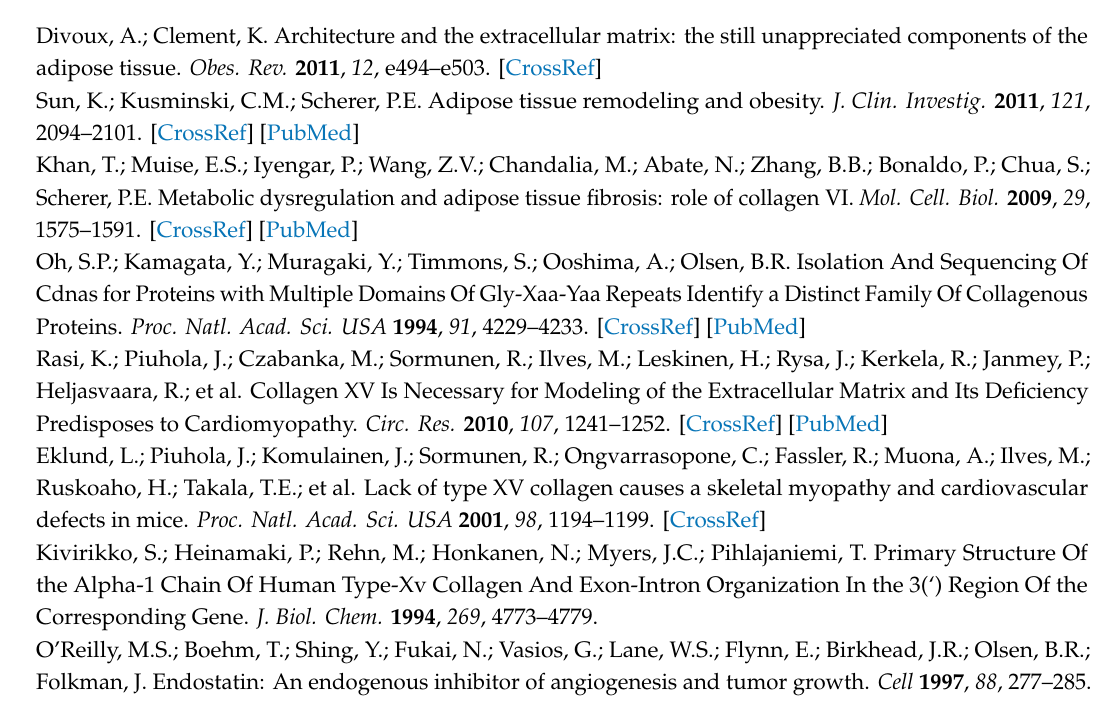
Figure S1: Carrier expression e ffi ciency and influence analyses. Figure S2: Z-stack analysis and three-dimensional reconstruction. Video S1: Z-stack and three-dimensional reconstruction of Collagen type I in Ad-ColXV group and Control group, Video S2: Z-stack and three-dimensional reconstruction of Collagen type VI in di ff erent groups (Control group, APMA group and co-treatment with APMA and Ad-ColXV group), Video S3: Z-stack and three-dimensional reconstruction of MMP-2 in Ad-ColXV group and Control group, Video S4: Z-stack and three-dimensional reconstruction of MMP-9 in Ad-ColXV group and Control